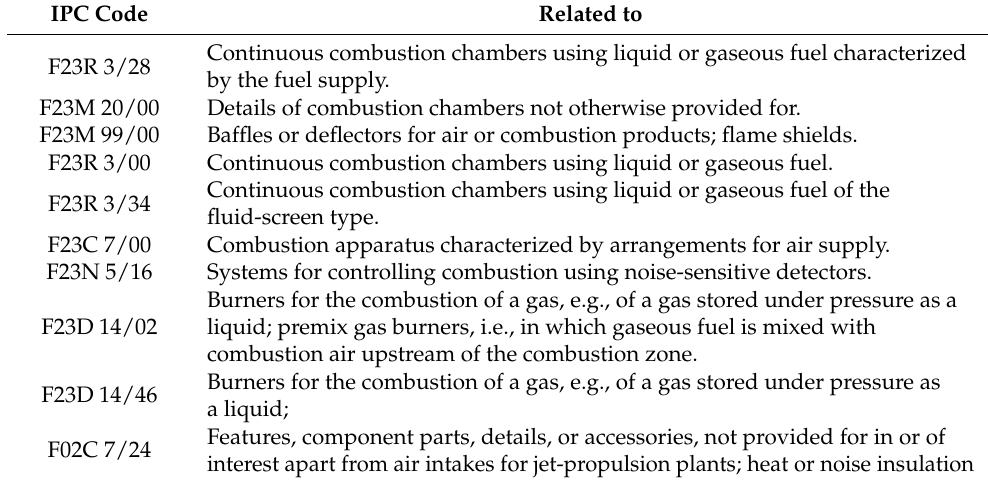
Figure 5. The major IPC codes used in the classification of the patent documents. Table 4. IPC codes used in this patent technology prospection.